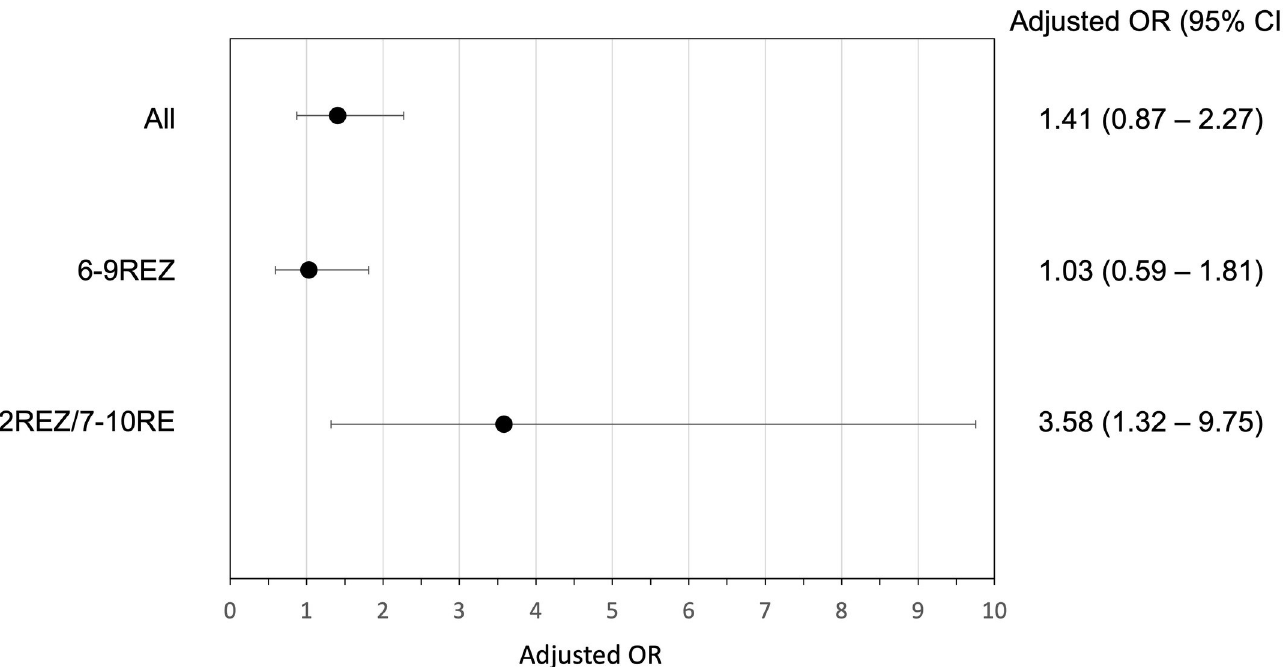
Fig 2. Forest plot of odds ratios of positive treatment outcome by additional fluoroquinolone use, stratified by initial baseline regimens. H, isoniazid; R, rifampicin; E, ethambutol; Z, pyrazinamide; Fq, fluoroquinolone; OR, odds ratio; CI, confidence interval.